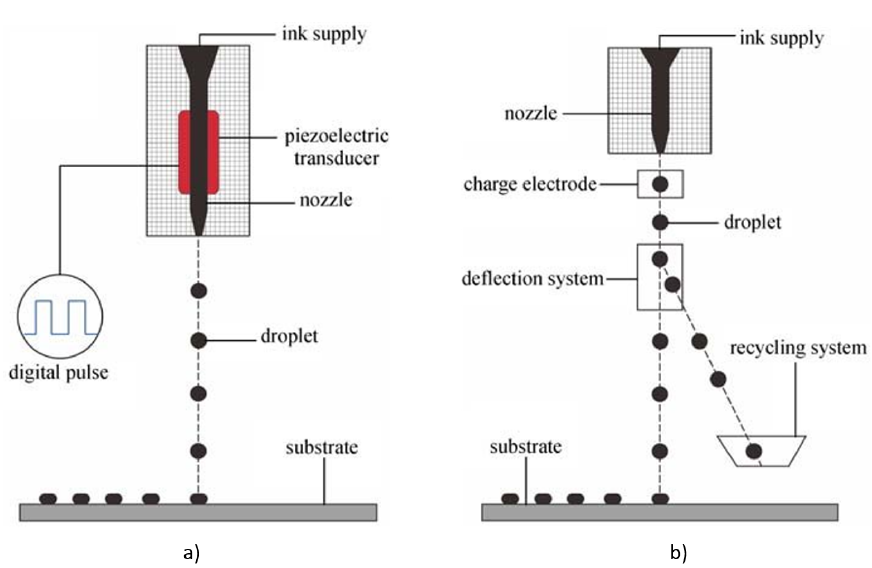
Figure 3. Schematic diagram of the inkjet printing processes. ( a ) DoD mode. ( b ) Continuous